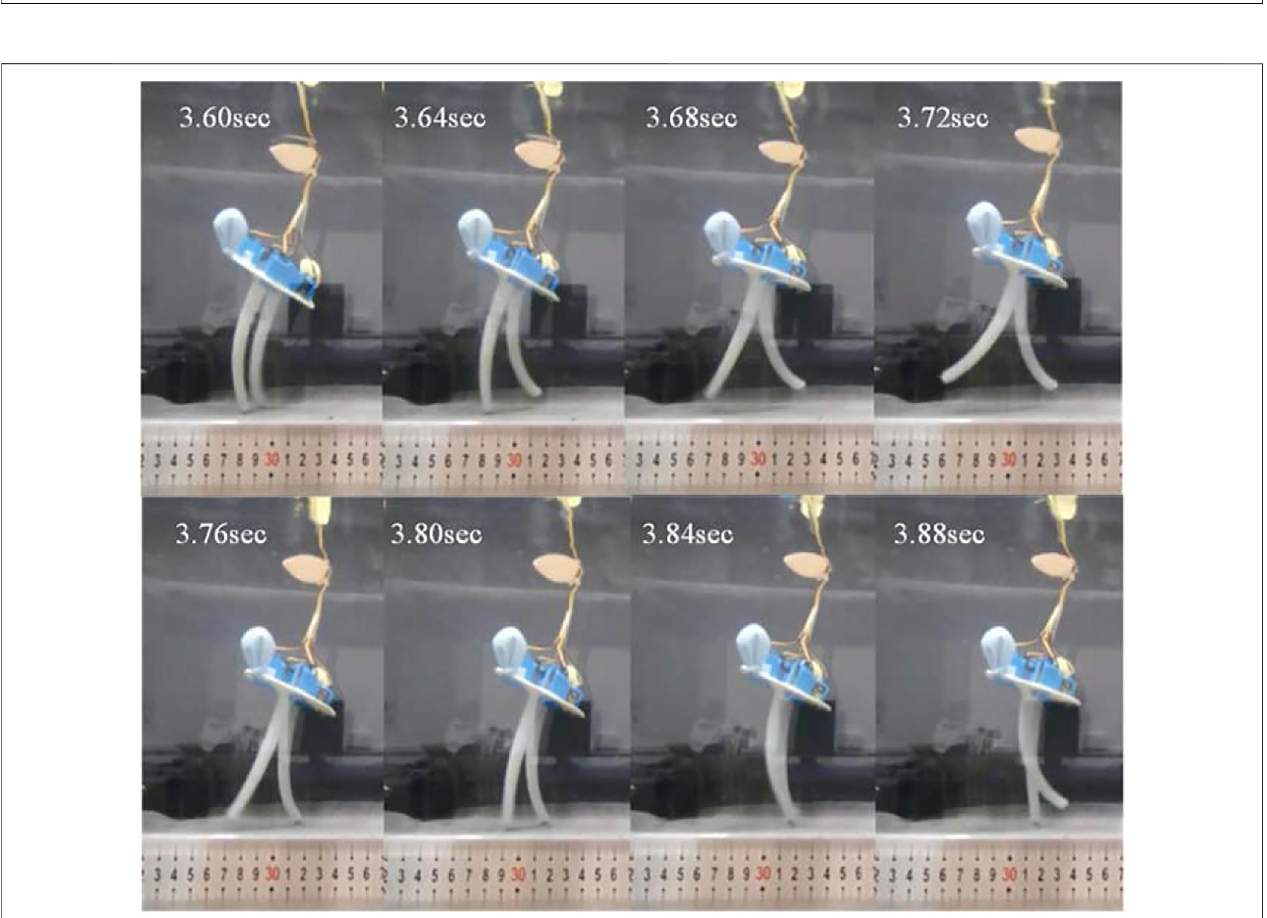
and the No.2 soft arm bends forward and leaves the ground. Action 4: The No.1 soft arm bends backward and pushes the